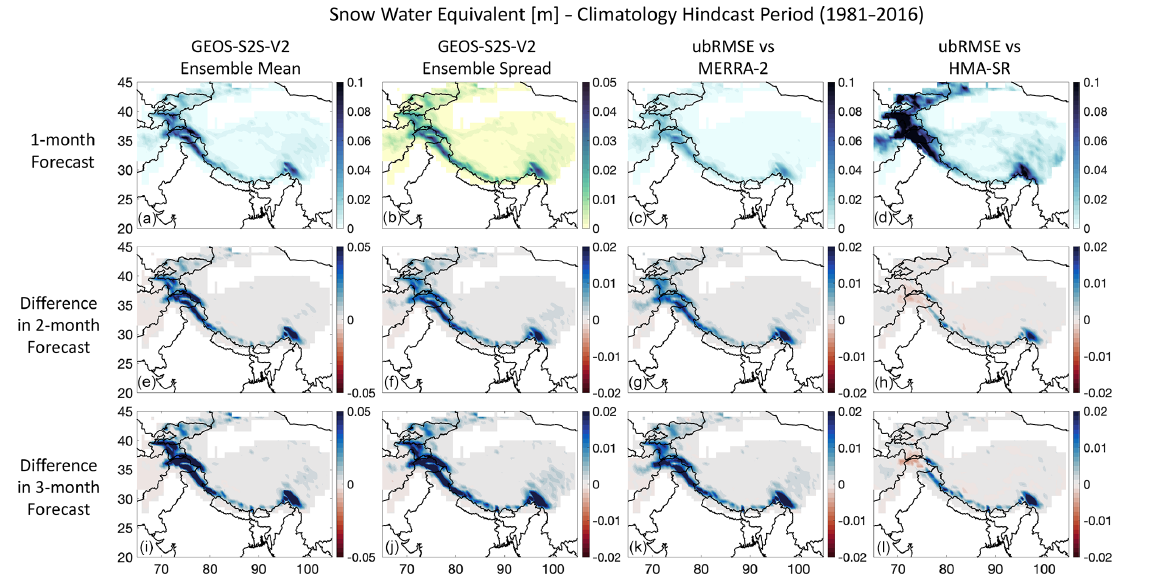
Figure 10. As in Fig. 7, but for snow water equivalent (SWE) in (m) and vs. HMA-SR in the right column. Grid cells that are masked out (in white) show areas with no-data values. Here, red in the subfigures indicates lower values (i.e., less snow water, smaller spread, or smaller error) in the 2- and 3-month forecasts, and blue indicates higher values compared to the 1-month forecasts.